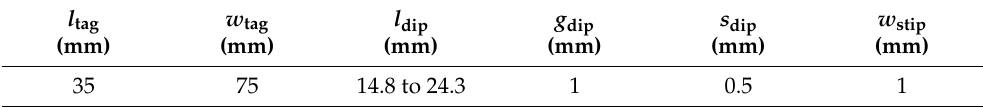
Table 1. Dimensions of shorted re-arranged U-dipole.